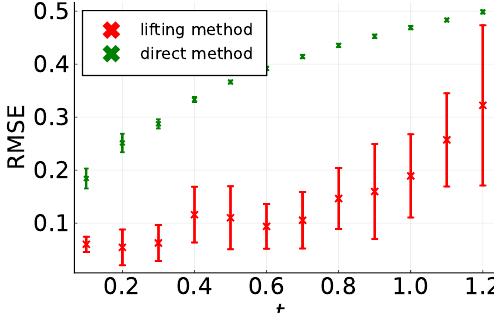
Figure 4. The lifting method is characterized by a smaller RMSE than a direct method based on least-squares regression of time derivatives. In particular, the error remains smaller for large sampling times. The dataset is generated with the dynamics in (18). Crosses and error bars show the mean and standard deviation, respectively, of the RMSE (over 50 experiments). Note that the experiments ( 1 ) − ˆ c ( 2 ) | > 1 for some i are discarded. characterized by | ˆ c i i